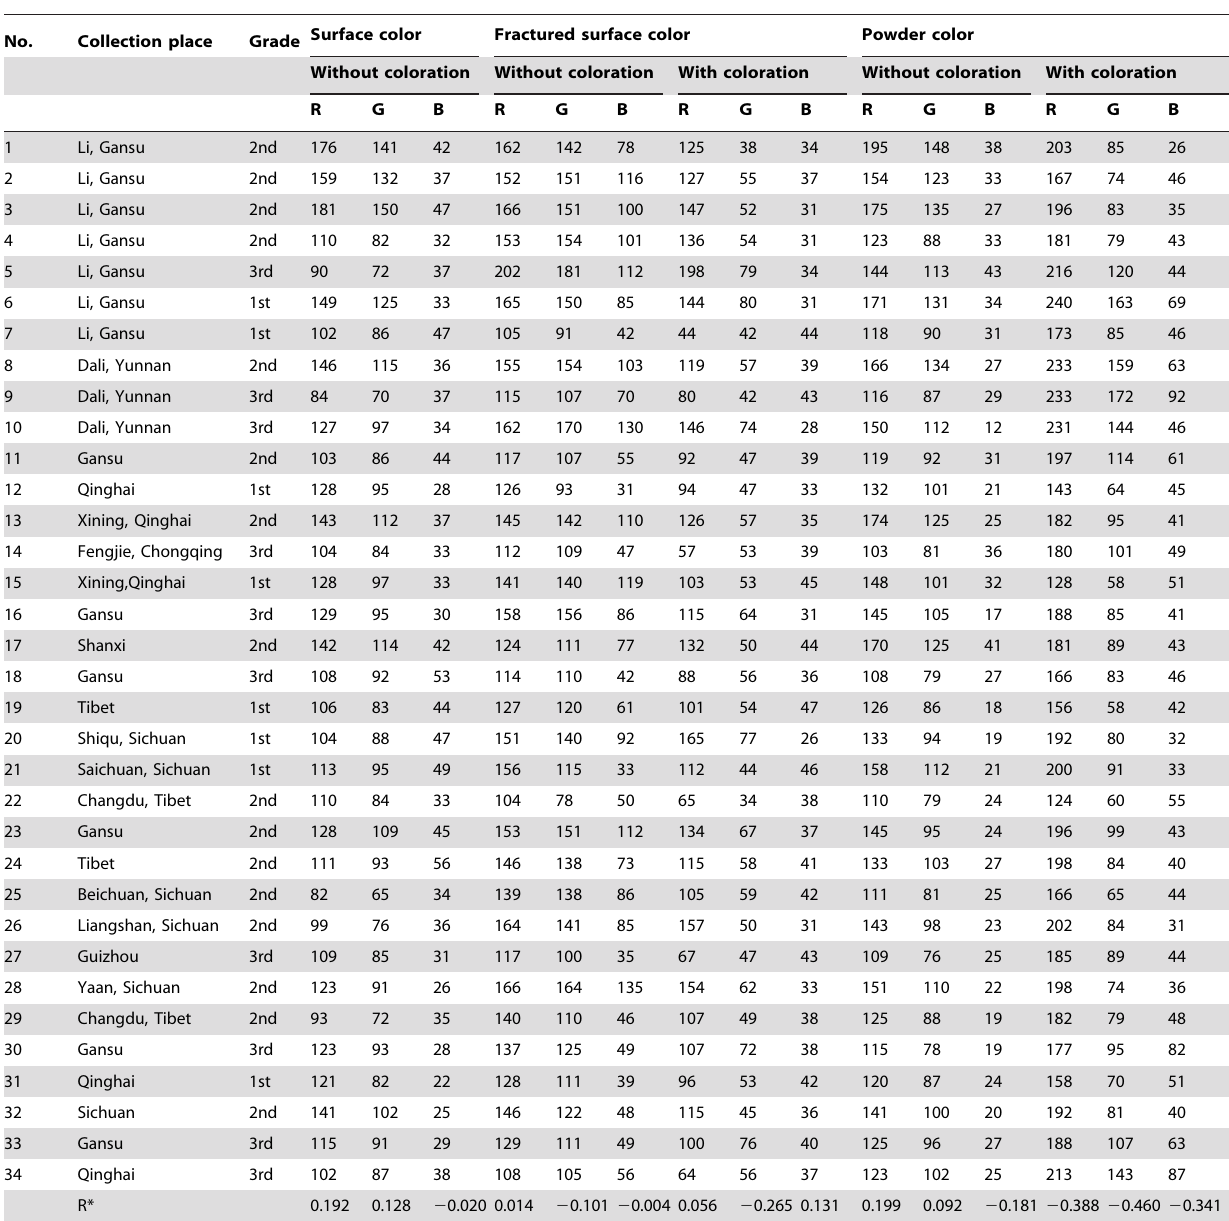
Table 1. RGB values of the color of the surface, the fracture surface and powder with or without further color development.